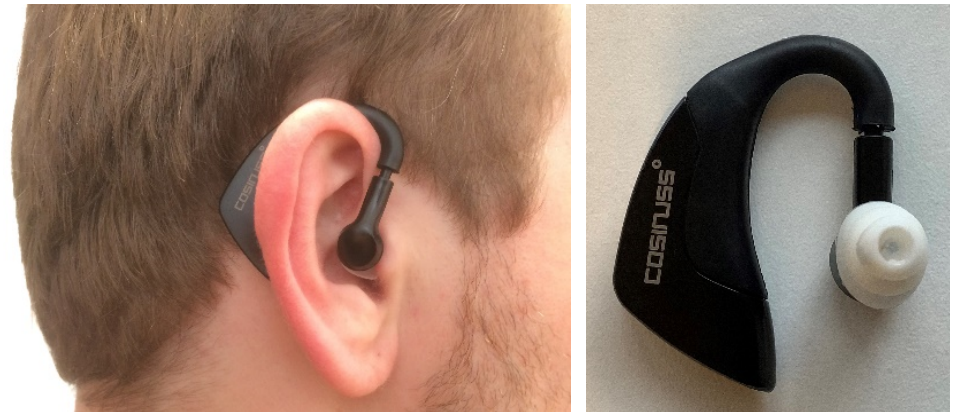
Figure 1. The wearable ear thermometer Cosinuss° °Temp. Left: Cosinuss° position in the ear. Right: Cosinuss° with IR sensor in the white ear tip.